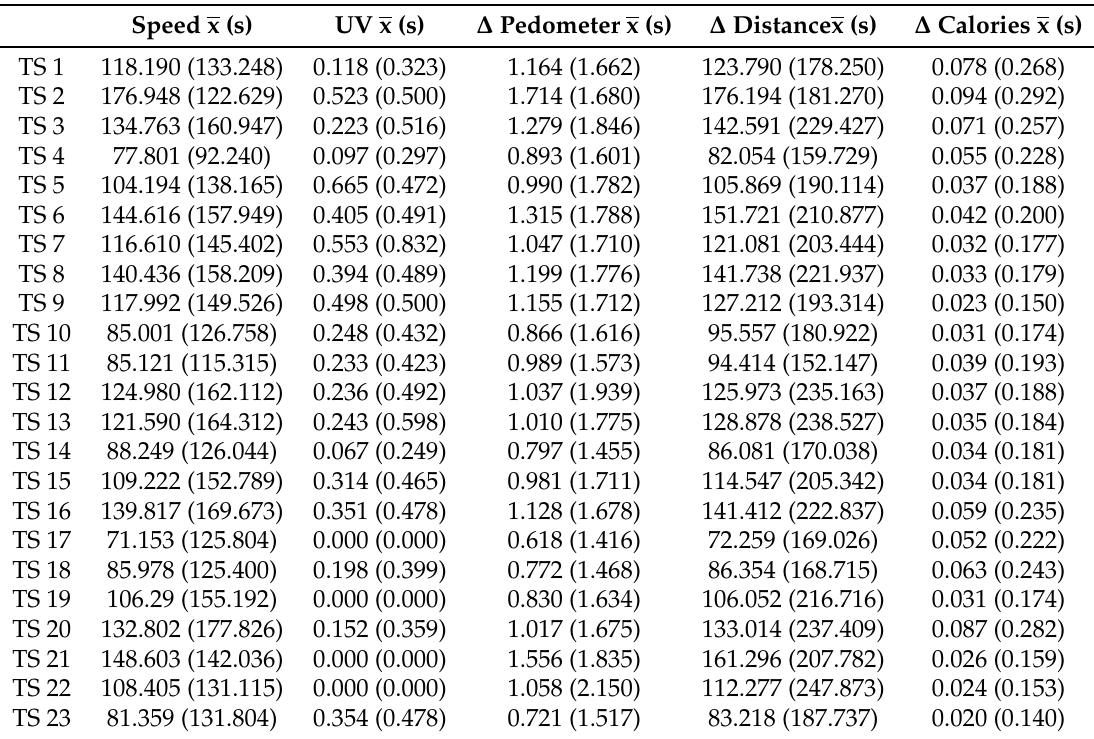
Table A6. Anomaly conditions dataset. Part